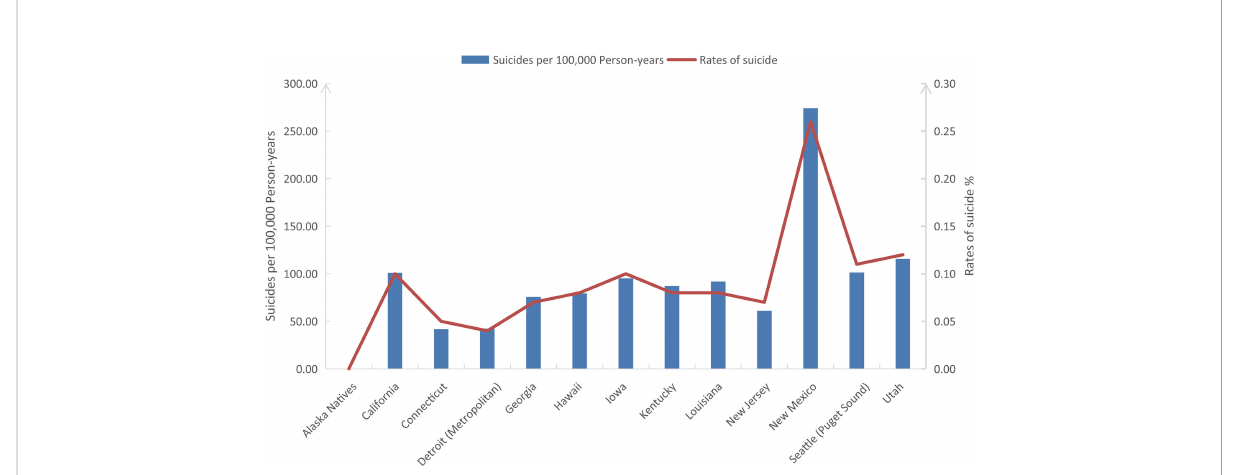
FIGURE 3 The overall suicide rates (%) and suicides per 100,000 person-years of pancreatic cancer patients in all SEER registered states from 2000 to 2018. SEER: Surveillance, Epidemiology, and End Results